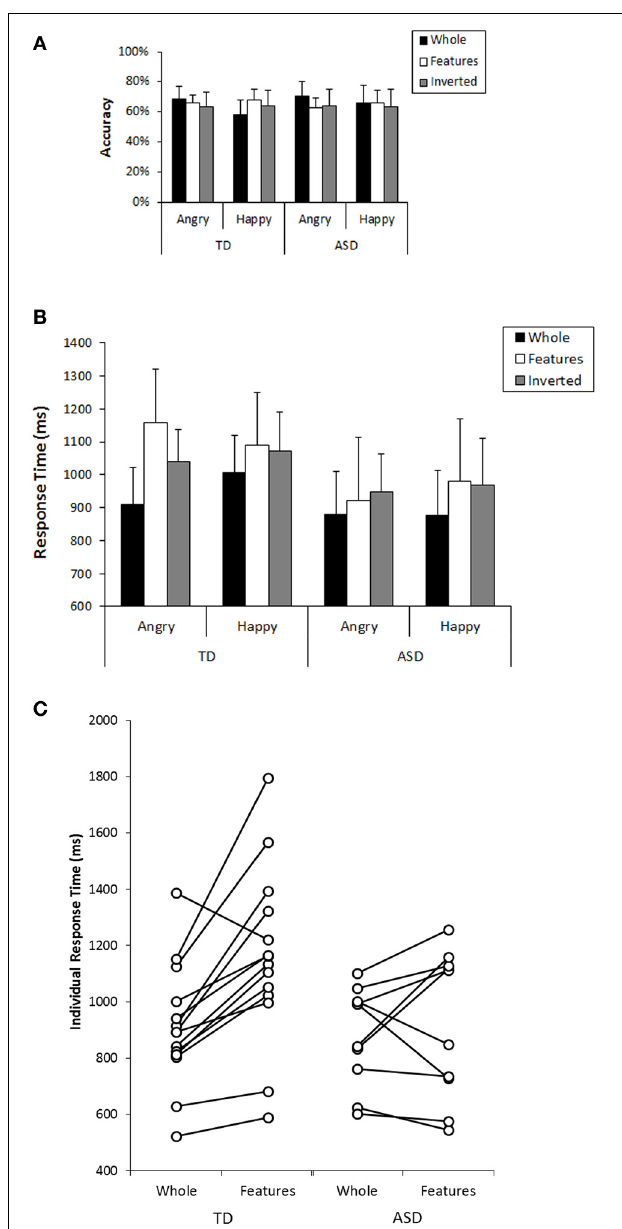
FIGURE 3 | (A) Mean accuracy in the recognition task for each condition in TD and ASD group. Error bars: 95% CI. (B) Mean response times in the recognition task for each condition in TD and ASD group. Error bars: 95% CI. (C) Comparison in the response times between recognition of angry whole faces and recognition of local features in angry faces in individual subjects in TD and ASD.